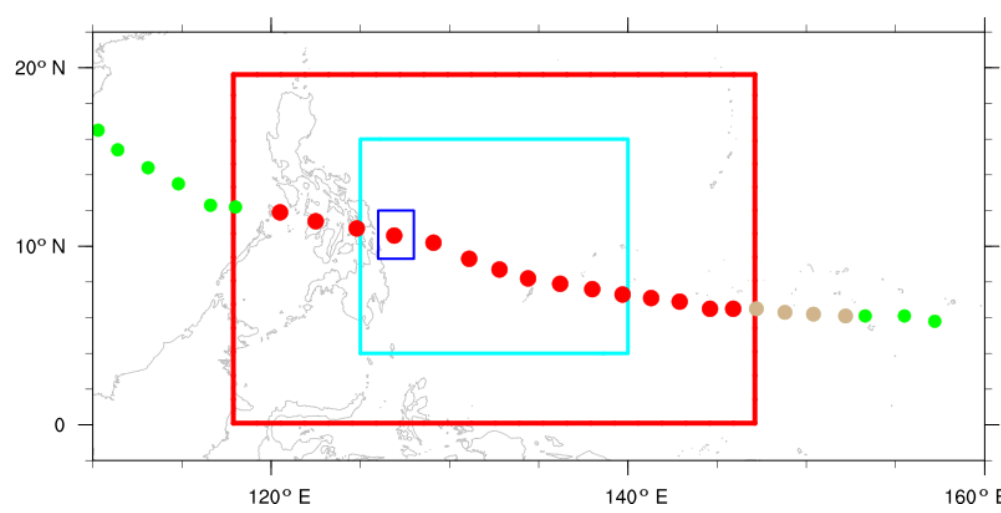
Figure 3. The model domain (red box) and calculation domains for the contoured frequency by altitude diagrams (blue box) and for energy spectra (cyan box). The red, tan, and green and dots represent the locations of Haiyan obtained from the best-track dataset. The red dots indicate the period of sensitivity experiments, the tan dots indicate the nudging period, and the green dots are the locations outside our simulation period. Table 1. Summary of the resolutions and surface flux options tested. The nudging period for all experiments is between 00:00UTC on 4 November 2013 and 00:00UTC on 5 November 2013, with an identical nudging setting for each resolution group using the default flux option (F0). Thereby the corresponding sensitivity experiments start with an identical initial TC (tropical cyclone) structure and location. The MCP and MSW indicate, respectively, the minimum central pressure at the TC center and maximum surface wind speed near the TC